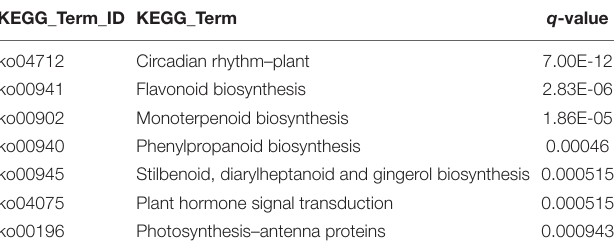
TABLE 1 | Enriched KEGG pathways in different expression genes (DEGs).